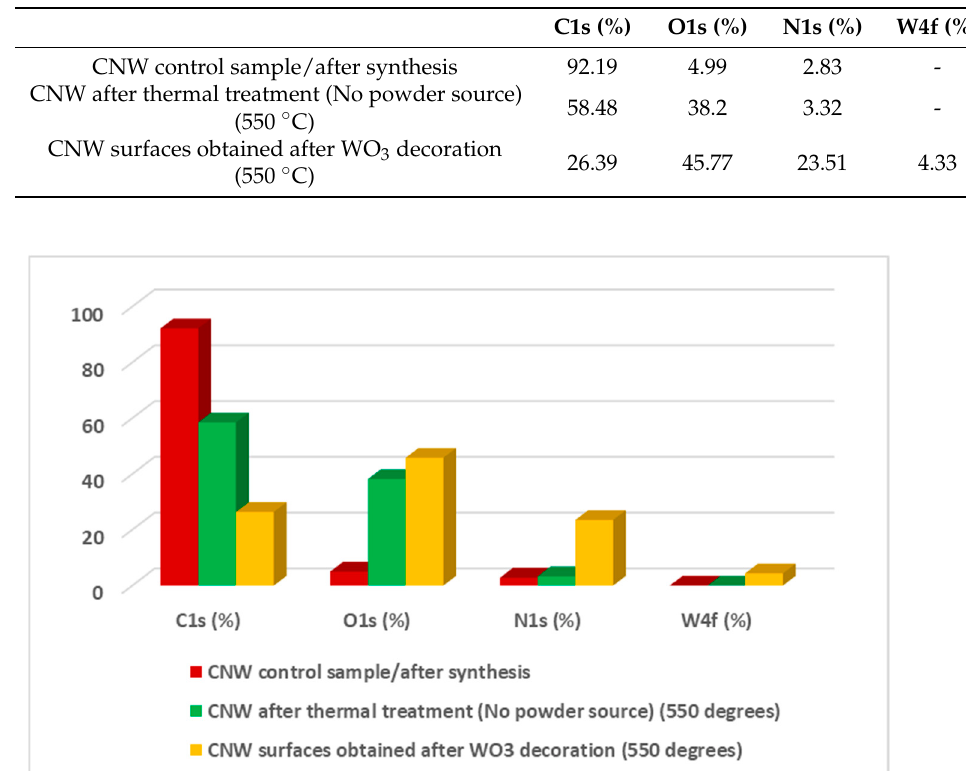
Figure 9. Bar diagram of the elemental composition corresponding with the four major zones (C1s, O1s, N1s, W4f) for all three investigated samples (CNW control sample, CNW after thermal treatments, respectively nanostructures obtained after WO 3 decoration) in plasma off condition.